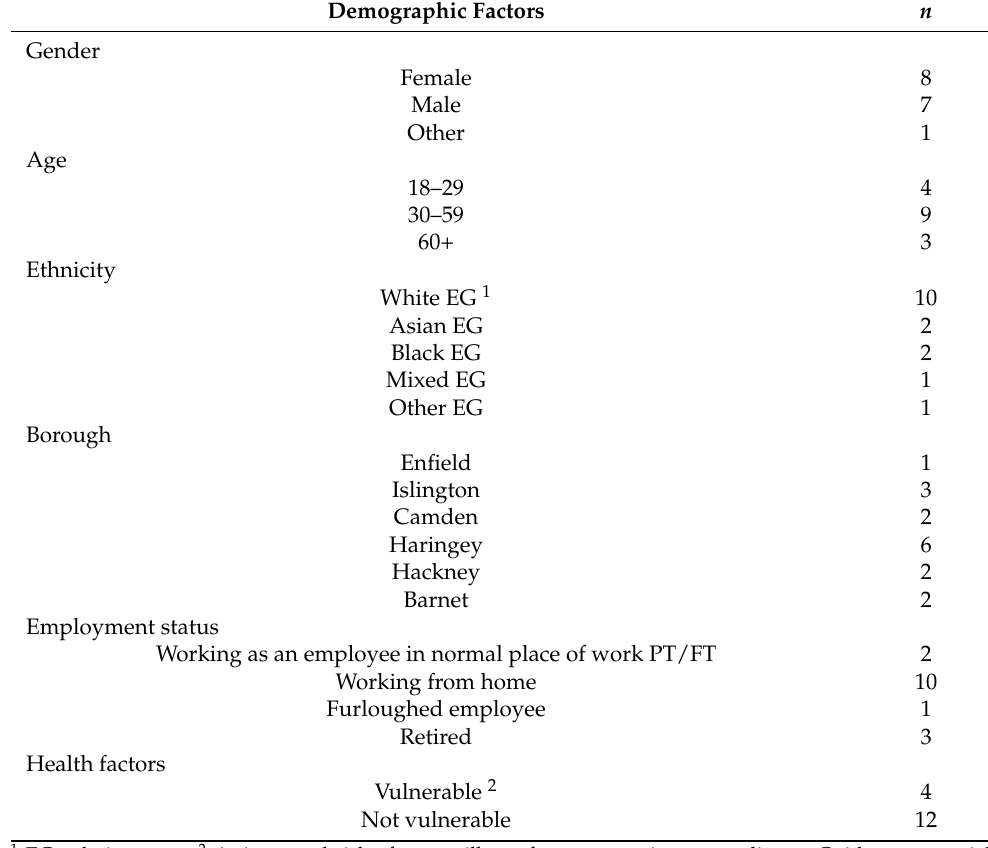
Table 6. Participant characteristics ( n = 16).